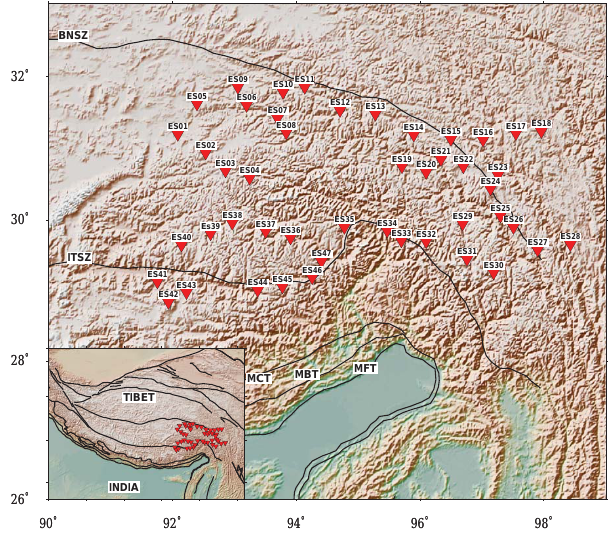
Figure 1. Tectonic and topographic map of the Himalayas and Tibet. Red triangles represent the broadband seismic stations of the XE network within the study region (MFT: Main Frontal Thrust; MBT: Main Boundary Thrust; MCT: Main Central Thrust; ITSZ: Indus–Tsangpo suture zone; BNSZ: Bangong–Nujiang su- ture